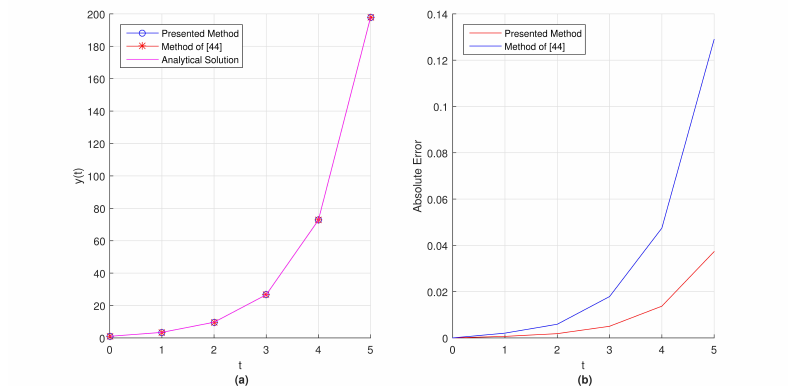
Figure 16. ( a ) The comparison of analytical solution and numerical solutions obtained by the proposed method and the method of [63] with m = 10. ( b ) The behaviour of the absolute errors between the exact solution and numerical solutions obtained by our method and the method given in [63] with m =